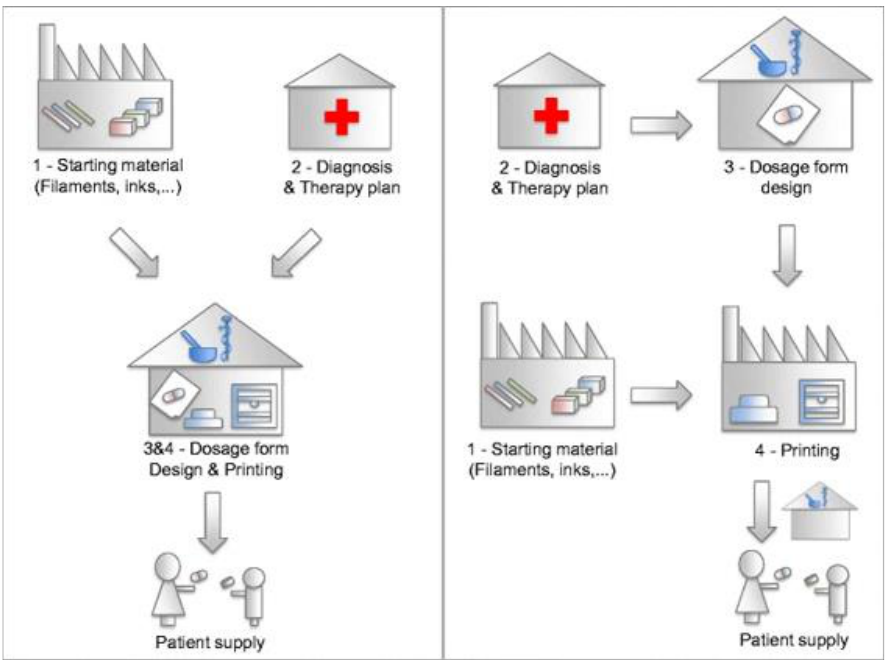
Figure 5. Two possible scenarios for the production of 3D-printed medicine: in the community pharmacy ( left ) or in the pharmaceutical industry ( right ). Both cases comprise an integral network between the proposed therapeutic plan, the design of a personalized dosage form, the utilization of the appropriate feedstock, and the production and final distribution of the medicinal product to the patient [55].